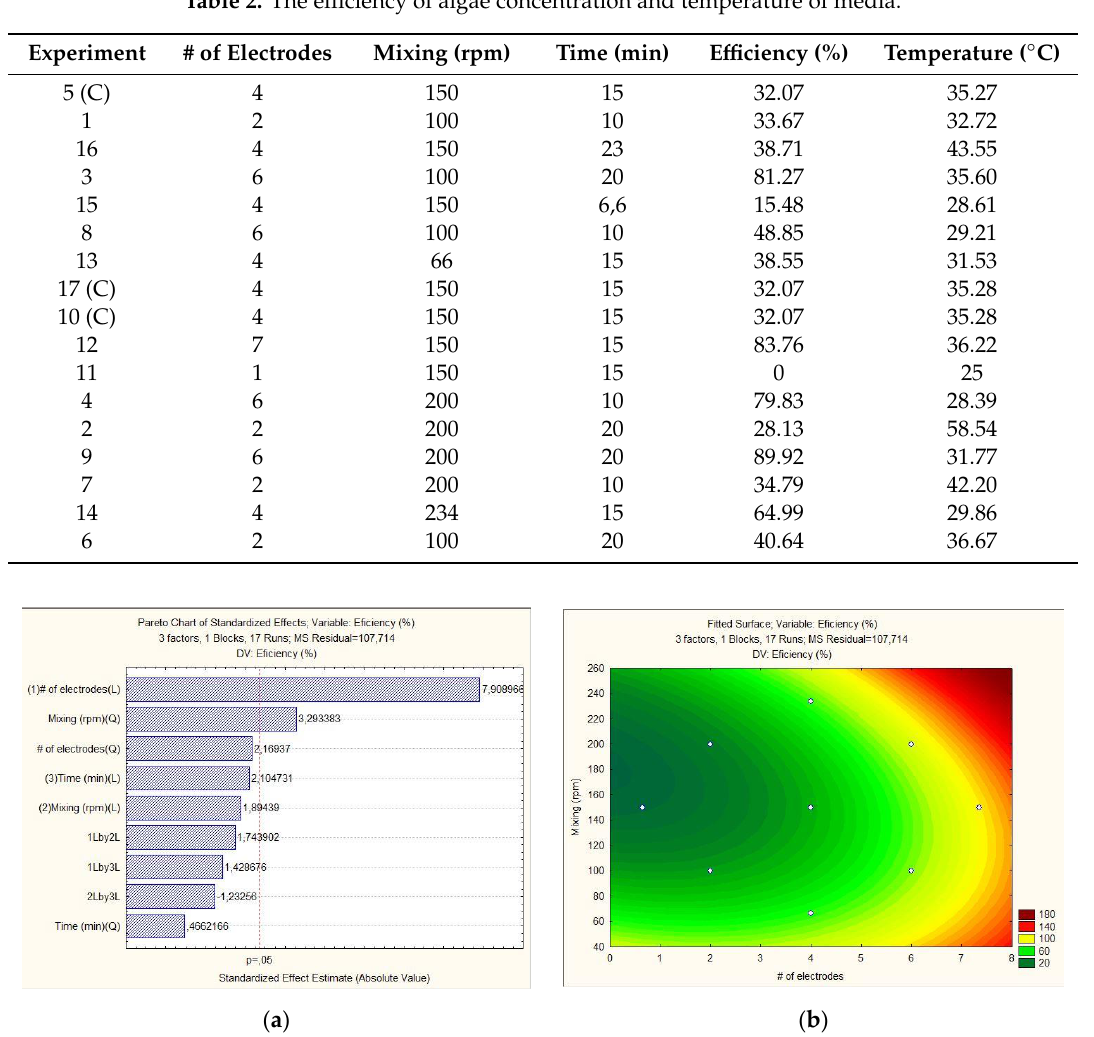
Figure 1. Pareto analysis of variables ( a ) and surface response between the most critical variables, mixing and number of electrodes ( b ).